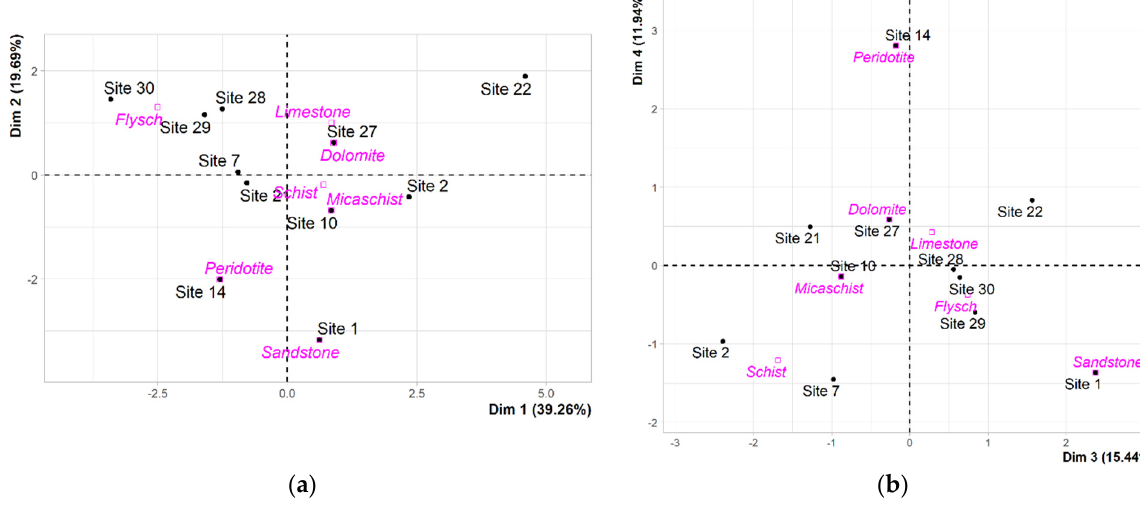
Figure 14. Graph of individuals. ( a ) According to axis 1 and 2; ( b ) according to axis 3 and 4.